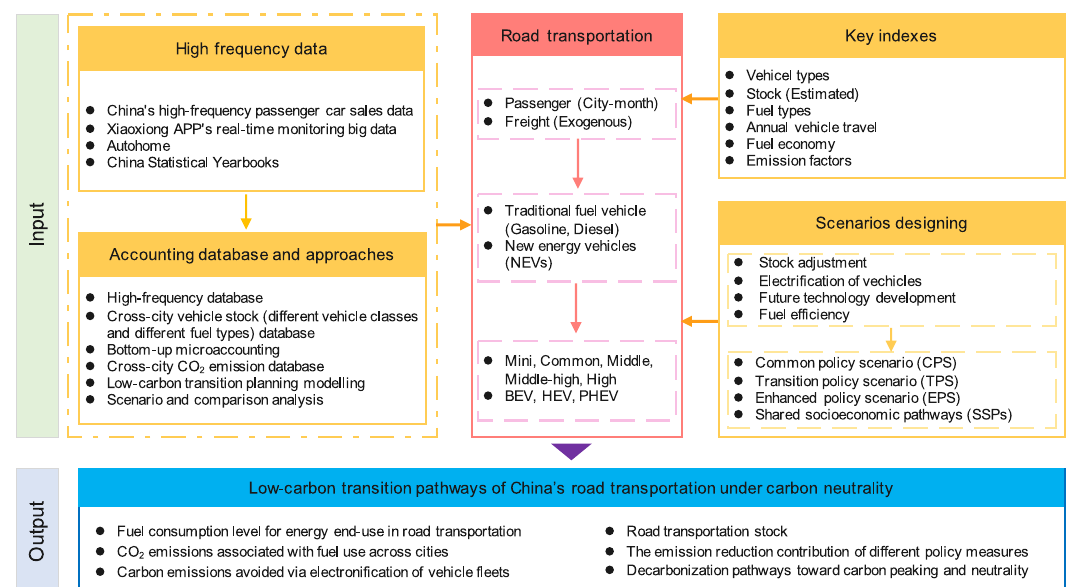
Fig. 1 Framework of high-frequency CO 2 accounting and decarbonization scenario analysis. (Input: Four databases for high-frequency historical accounting, including cross-city vehicle stock and cross-city CO 2 emissions based on the bottom-up microaccounting method; decarbonization scenarios of low-carbon transportation transition based on key indexes; the carbon reduction contribution of different policy via the proposed CRT-LCTP model. Output: low-carbon transition pathways of China ’ s road transportation toward carbon